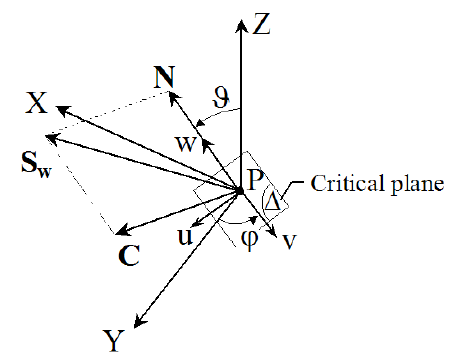
Figura 2: PXYZ and Puvw coordinate systems, with the w -axis normal to the critical plane  . The stress